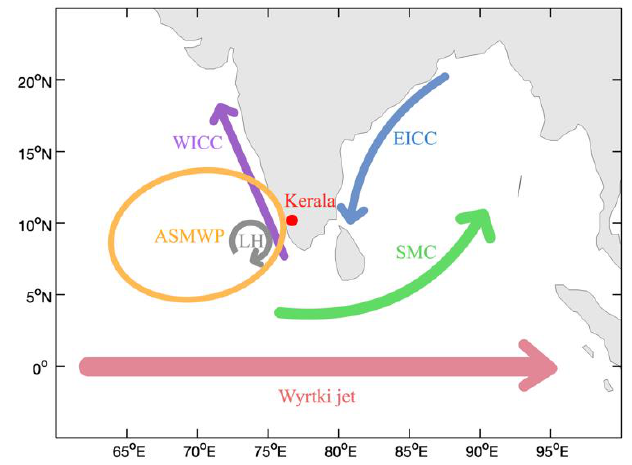
Figure 14. Schematic of the processes associated with the salinity anomalies in 2010. BoB is characterized by a low SSS while the Arabian Sea features a high SSS. The SMC (green arrow) in the summer monsoon season and the Wyrtki jet (pink arrow) in October flowed father eastward, causing more high-salinity water to move into the northern BoB in 2010. In addition, the EICC (blue arrow) was stronger in October 2010, resulting in extremely negative salinity anomalies around Sri Lanka and positive salinity anomalies in the northern BoB. Most of the freshwater was then transported to SEAS by WICC (purple arrow) and trapped by LH (gray arrow). Then, it could influence the formation of the barrier layer there in winter 2010 and the ASMWP (yellow circle) in spring 2011. Subsequently, the ASMWP affects the low-pressure system known as MOV over the SEAS. The MOV often deepens into a cyclonic storm followed by the strengthening of westerlies. The westerlies lead to sustained rainfall over Kerala (red dot), heralding the onset of the summer